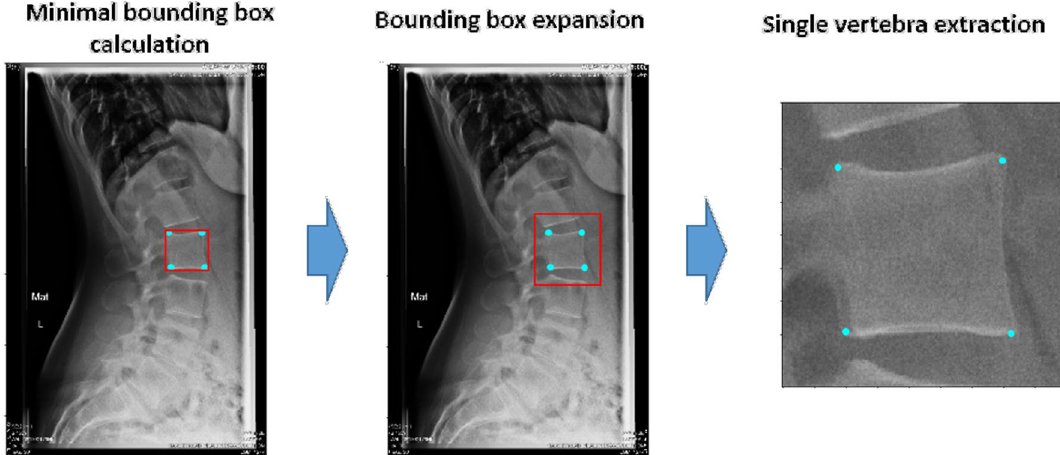
Figure 9. Example of the extraction of a single vertebra image for L2 vertebra. We used a process that will be applicable also during the testing phase or in the clinical practice without manual